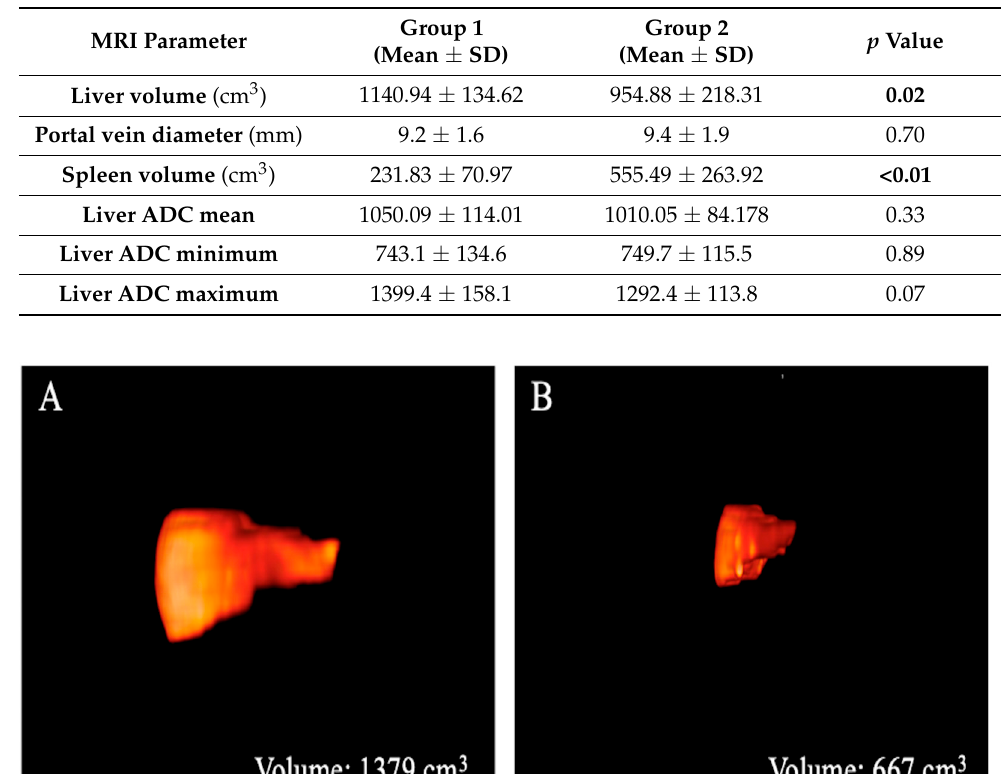
Table 5. Results of the quantitative MRI parameters of the patients in both groups.